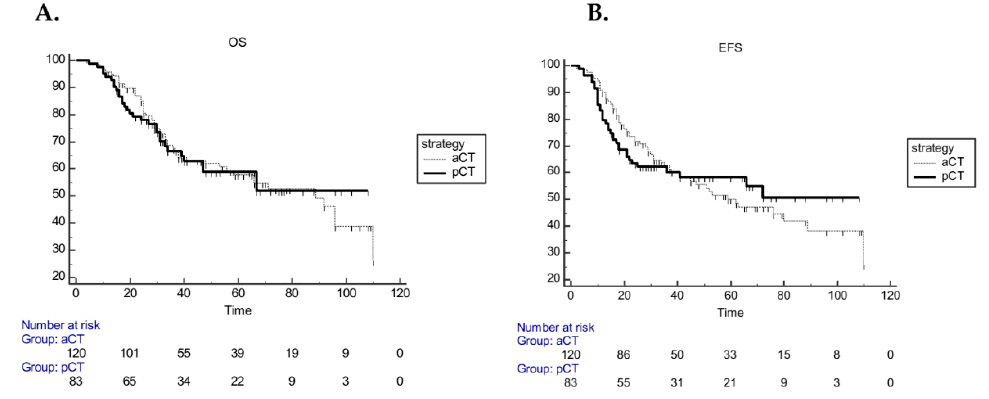
Figure 2. Kaplan–Meier curves for OS ( A ) and EFS ( B ) according to strategy (pCT vs. aCT).